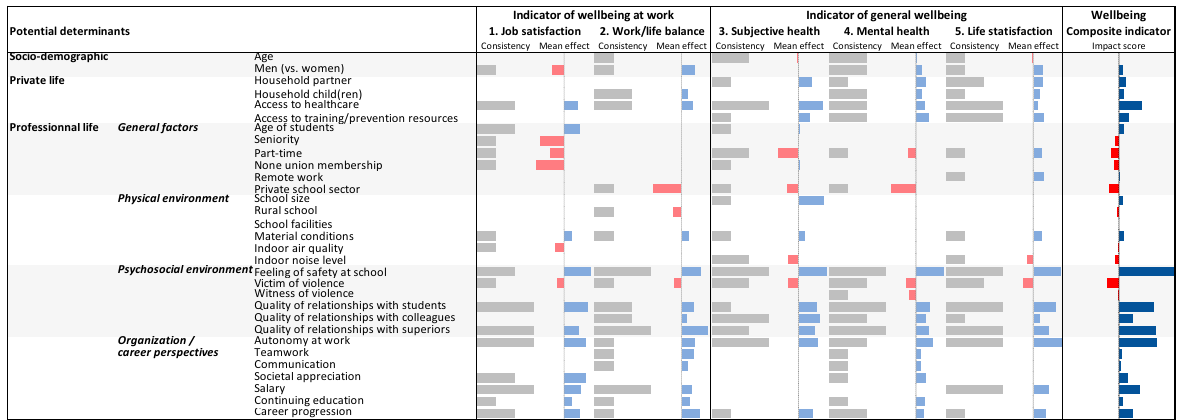
Figure 3. Consistency, mean effect and synthetic impact score for 31 potential determinants of teachers’ wellbeing at work in France, Québec, Belgium, 2021 International Barometer of Education Personnel’s Health and Wellbeing (I-BEST). (Consistency = number of “cofactor × wellbeing-indicator” association(s) that was(were) found to be significant among the 3 wellbeing indicator models performed in France, Québec, Belgium, using a stepwise forward stepwise regression procedure (0 = “null effect observed systematically” to “3 = significant association observed systematically”). Mean effect = mean of the corresponding (significant) beta(s) (red denotes a negative significant effect, blue a positive significant effect, the size of the bar giving the amplitude of the effect). Impact score = average of the mean effect weighted by the consistency across the five wellbeing indicators studied).